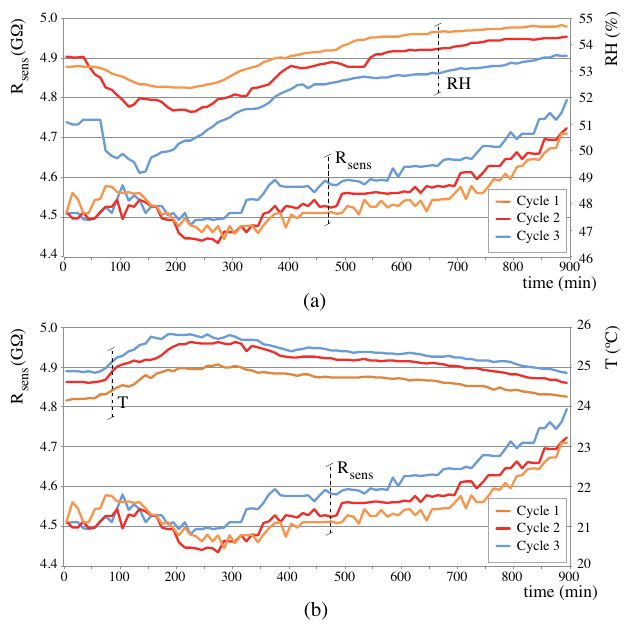
Figure 7. Resistance value results for Maritime pine-sample A. Three 15-h acquisition cycles at 6 values per hour, with 9-h rest cycle between them. Top: Resistance vs. RH; bottom: Resistance vs. Temperature. Small changes in either temperature or RH are captured by the circuit, impacting on R sens .